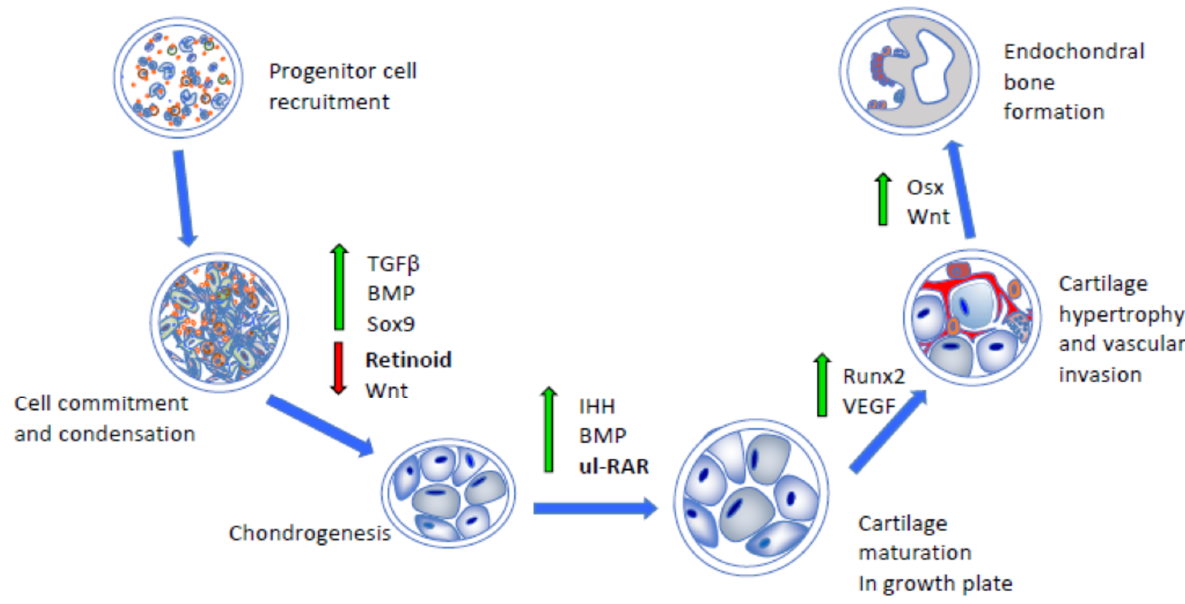
Figure 1. Schematic depicting the major developmental steps during endochondral bone formation. Following progenitor cell commitment and condensation (left panels), chondrogenic differentiation, cartilage maturation, hypertrophy, and vascular invasion require the concerted and stage-dependent up-regulation of indicated pathways and transcription factors (middle panels, green arrows). This leads to replacement of hypertrophic cartilage with bone (upright panel). Importantly, chondrogenesis and cartilage maturation require down-regulation of antagonistic pathways, such as retinoid and Wnt signaling (red arrow), as well as action by unliganded RNA receptors exerting transcriptional repression ( ul-RAR ). TGFβ, transforming growth factor β; BMP, bone morphogenetic protein; IHH, Indian hedgehog; VEGF, vascular endothelial growth factor; Osx, osterix.